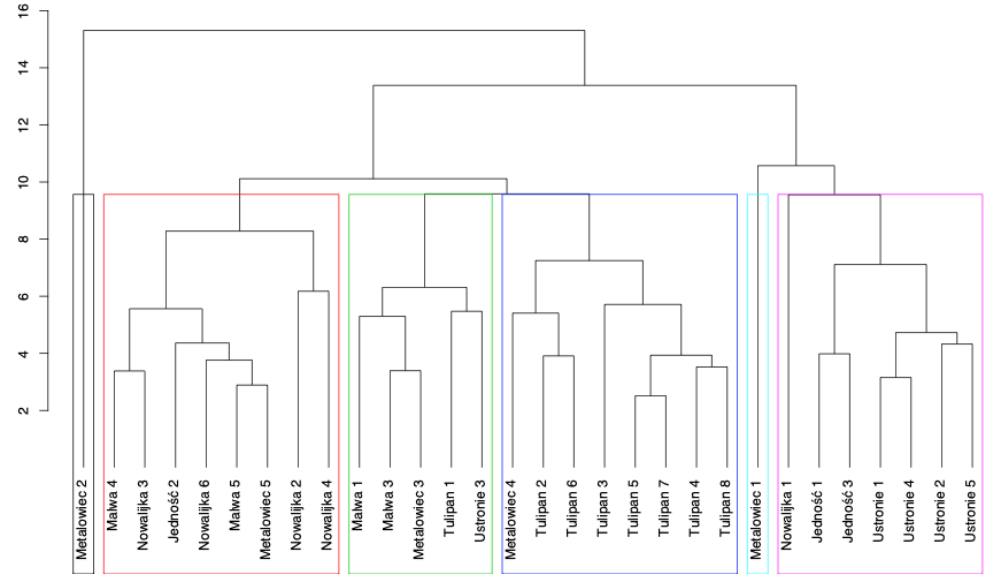
Figure 3. Dendrogram of 31 allotment plots calculated on the basis of soil parameters.